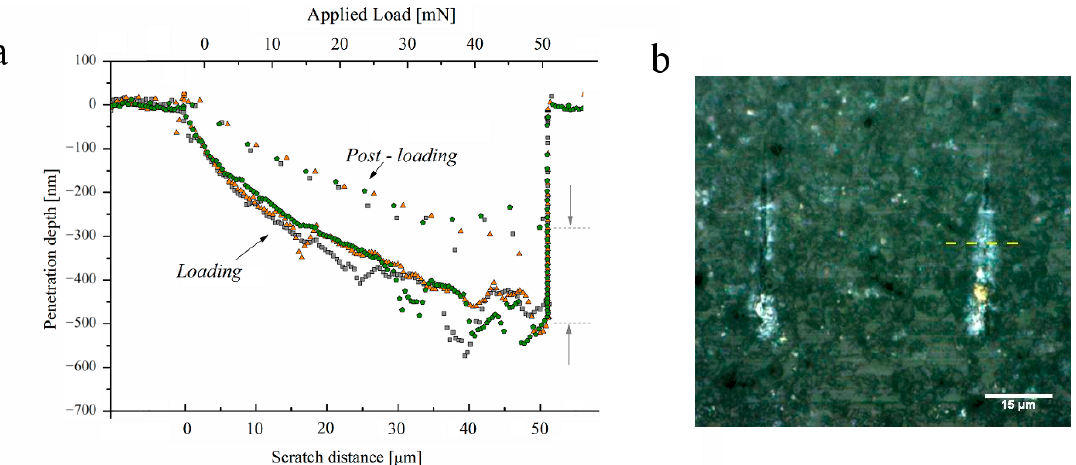
Figure 2. ( a ) Penetration depth as a function of scratch distance and applied load for scratches per- formed at the low-load condition; loading and post-loading stages are shown. ( b ) Optical micrograph of the scratches at P max = 50 mN - l max = 50 µm.